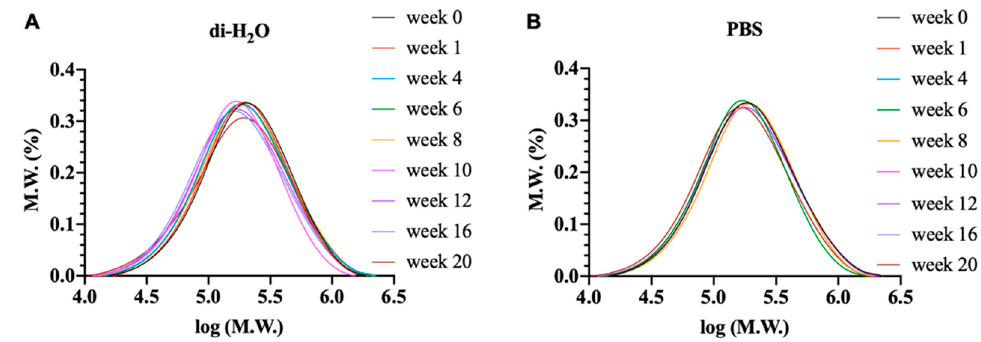
Figure 5. GPC curves of electrospun PLGA scaffolds degraded in ( A ) PBS and ( B ) di ‐ H 2 O at 37 °C at marked degradation time. marked degradation